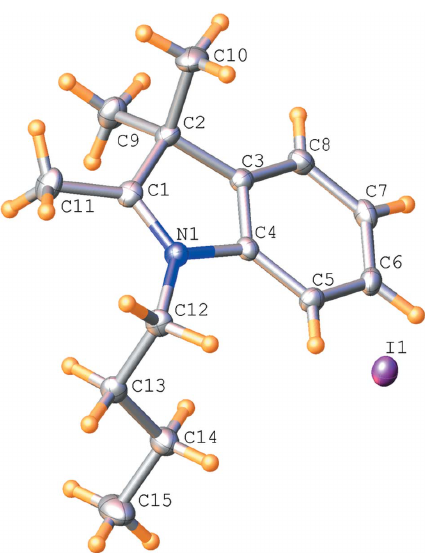
Figure 1 The molecular structure of the title compound, with displacement ellipsoids shown at the 50% probability level.